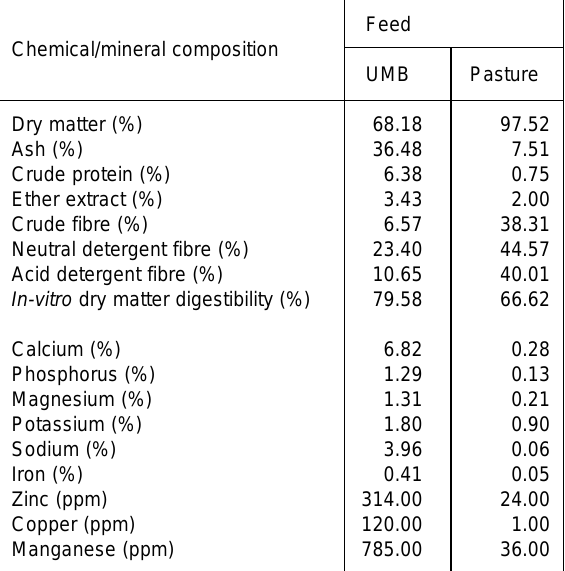
TABLE 1 Chemical and mineral composition of the dietary urea- molasses block (UMB) and pasture Feed Chemical/mineral